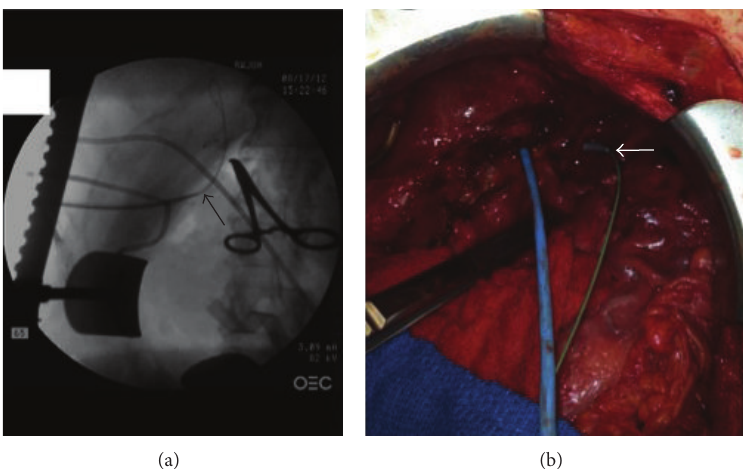
Figure 5: Intraoperative radiographically guided tunneling of biliary catheters. (a) Intraoperative radiograph showing interventional radiologist tunneling 16 gauge Colapinto needle through the previously placed posterior sectoral sheath (Cook Medical Inc, Bloomington, In). A guidewire traversing regenerated liver into the peritoneal cavity is demonstrated (arrow). (b) Operative field view with a catheter in the anterior ductal system inserted retrograde from the bile duct and out the liver surface and abdominal wall (arrow) and the posterior catheter inserted from an outside-in direction.